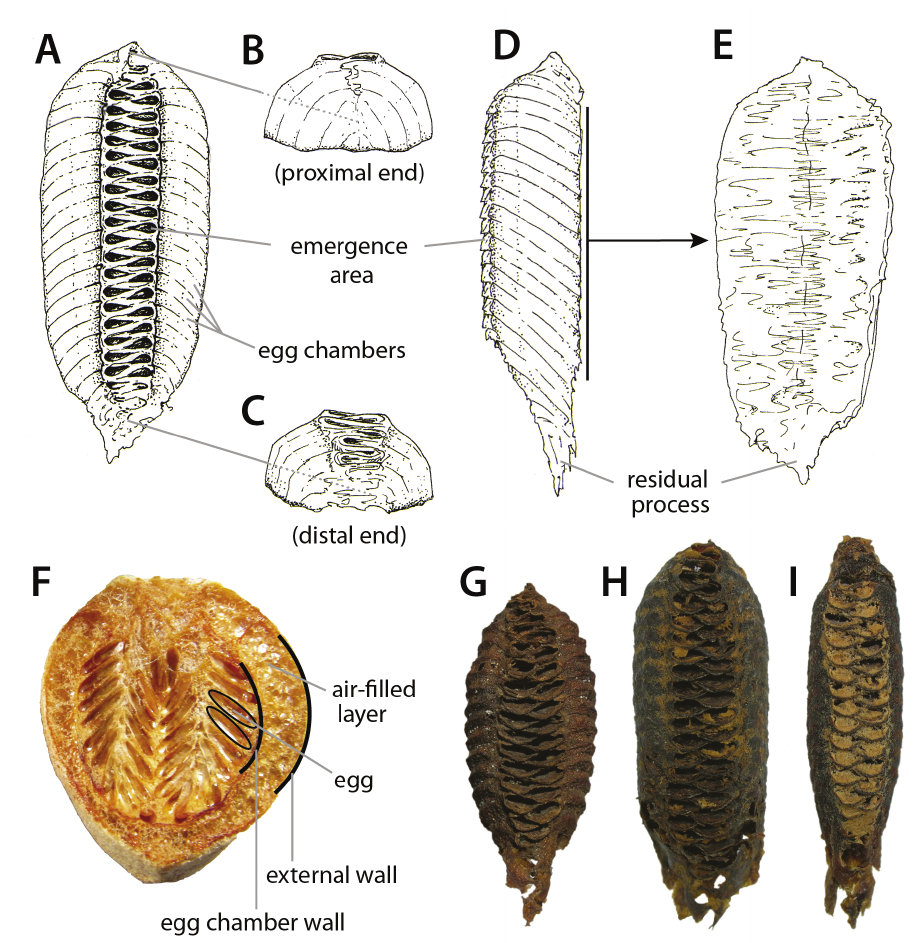
Figure 20. General ootheca morphology. A – E Annotated illustrations of a generic ootheca: A dorsal view B rear view C frontal view D lateral view E ventral view F internal view of a bisected egg case, species unknown. Example of interspecific variation of ootheca morphology ( G – I ) G Choeradodis rhombicollis Latreille, 1833 H Choeradodis stalii Wood-Mason, 1880 I Choeradodis columbica Beier, 1931. Illustrations and photographs courtesy of Hiromi